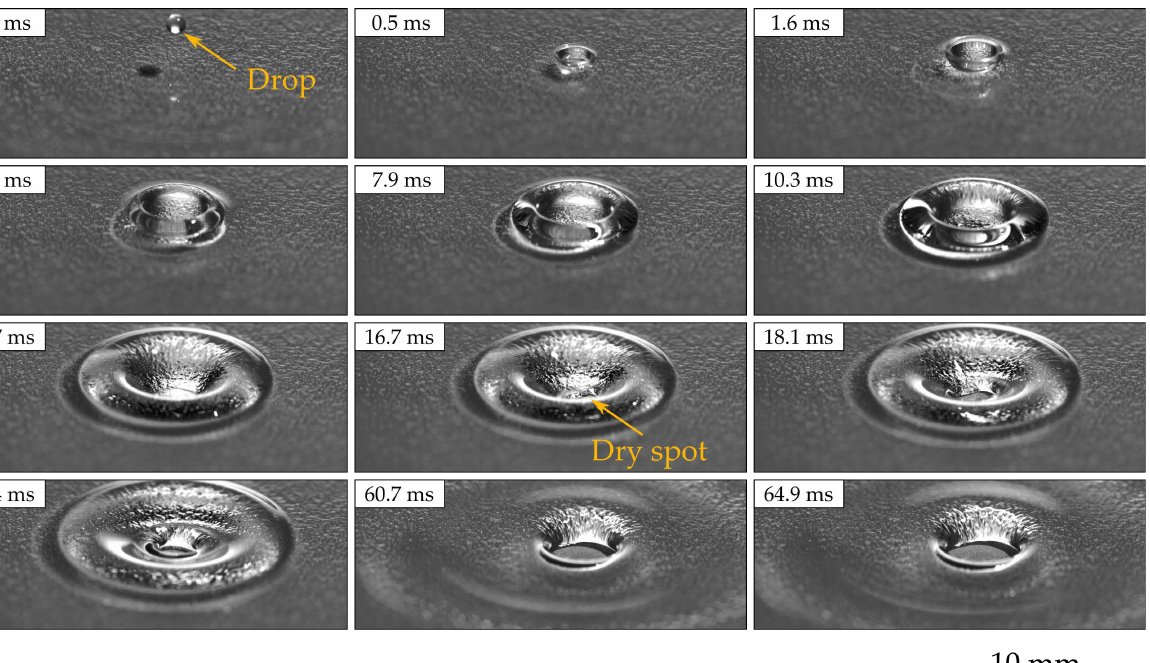
Figure 2. Dry spot formation in a liquid film on a superhydrophobic surface after droplet impact for the case of aqueous glycerol solution with viscosity µ = 15 mPa · s. The droplet velocity— U = 3.3 m/s, diameter— D = 1.9 mm, and film thickness— h = 3.1